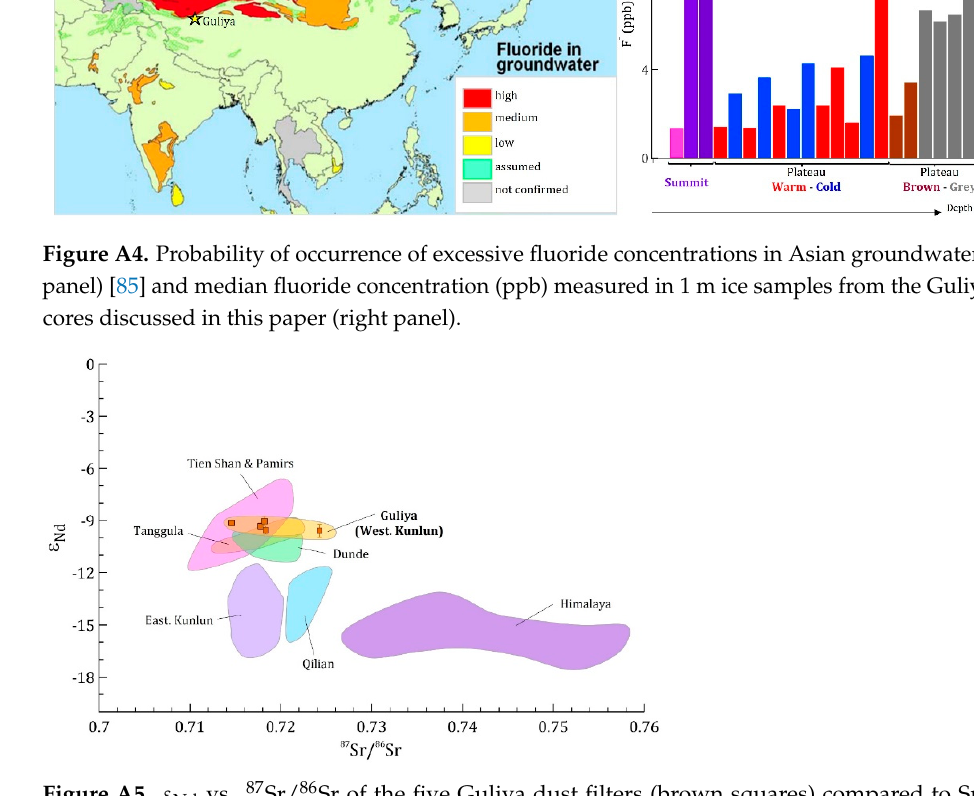
Figure A5. ε Nd vs. 87 Sr/ 86 Sr of the five Guliya dust filters (brown squares) compared to Sr and Nd isotopic arrays of dust sampled in surface snow and shallow ice cores from Tien Shan and Pamirs [43,48], Tanggula, East Kunlun, Qilian [48], Dunde [35], and Everest (Himalaya) [44].